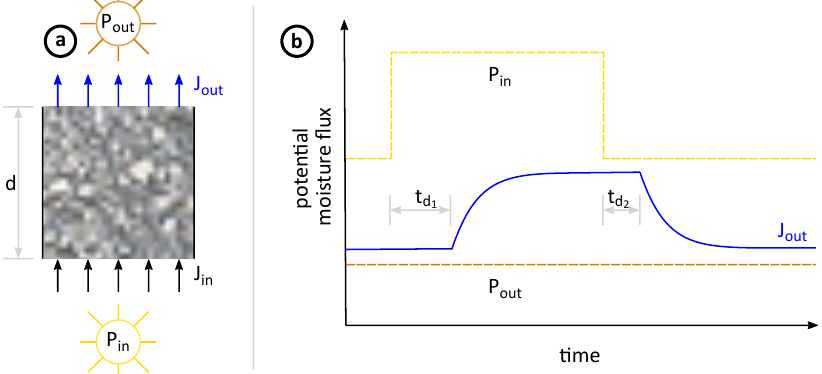
Figure 9. Moisture flux through a thick structure including